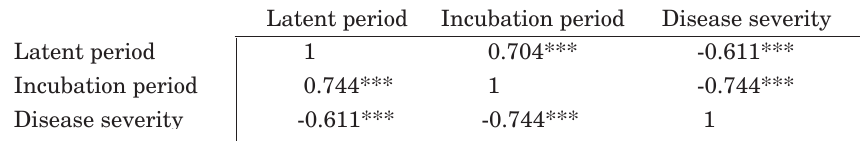
Table 4. Pearson linear correlation coefficient between three aggressiveness components measured across seven